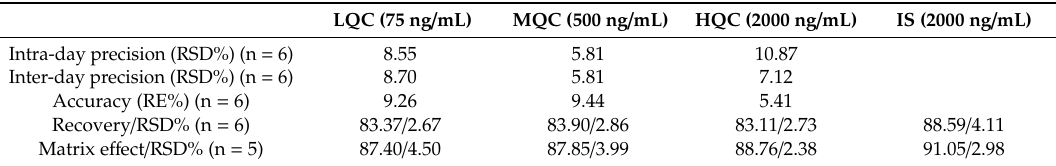
Table 4. Validation of the nimodipine determination method in plasma.